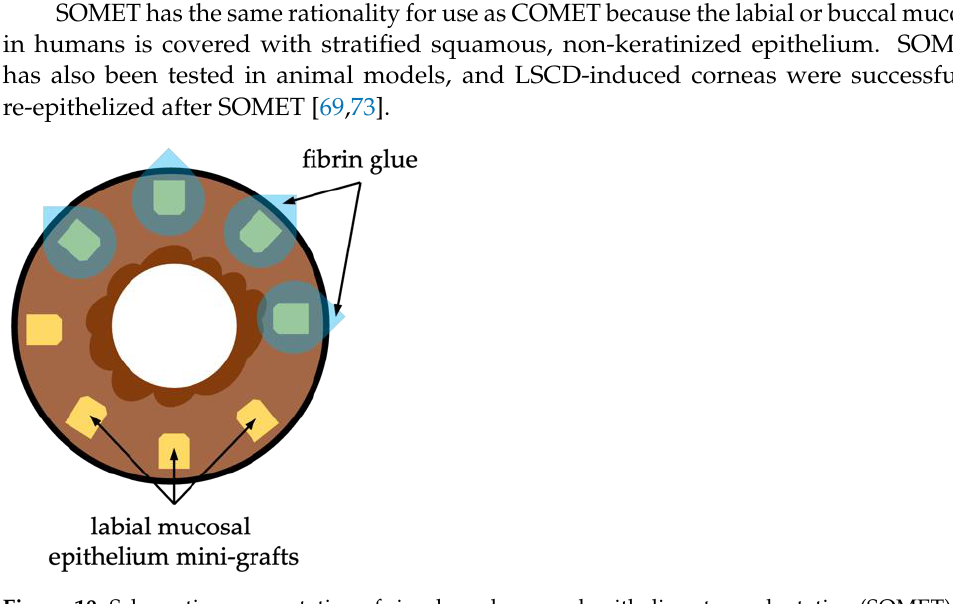
Figure 10. Schematic representation of simple oral mucosal epithelium transplantation (SOMET) for corneal re-epithelization in bilateral LSCD. Labial mucosal epithelium graft is divided into mini-grafts and attached to the affected cornea with the fibrin glue.